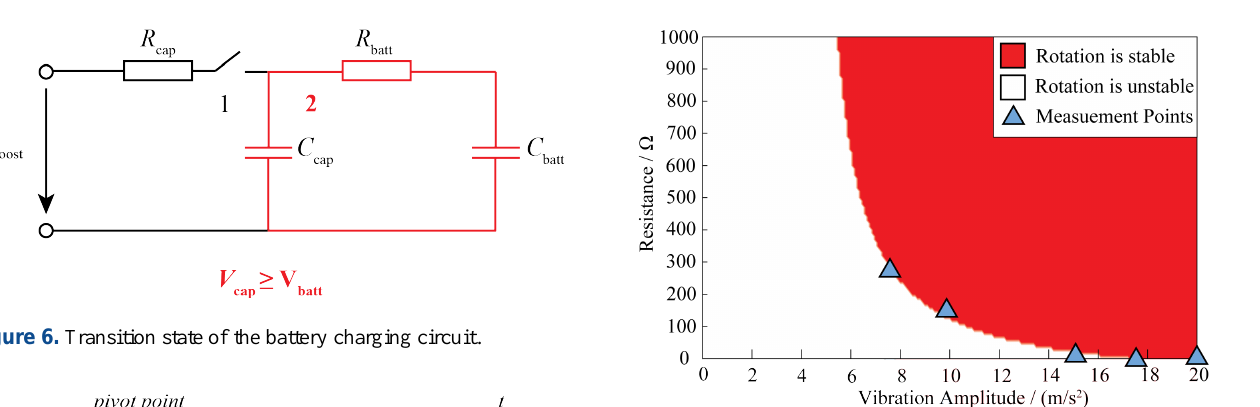
Figure 7. Geometry and orientation of the rotational mass.